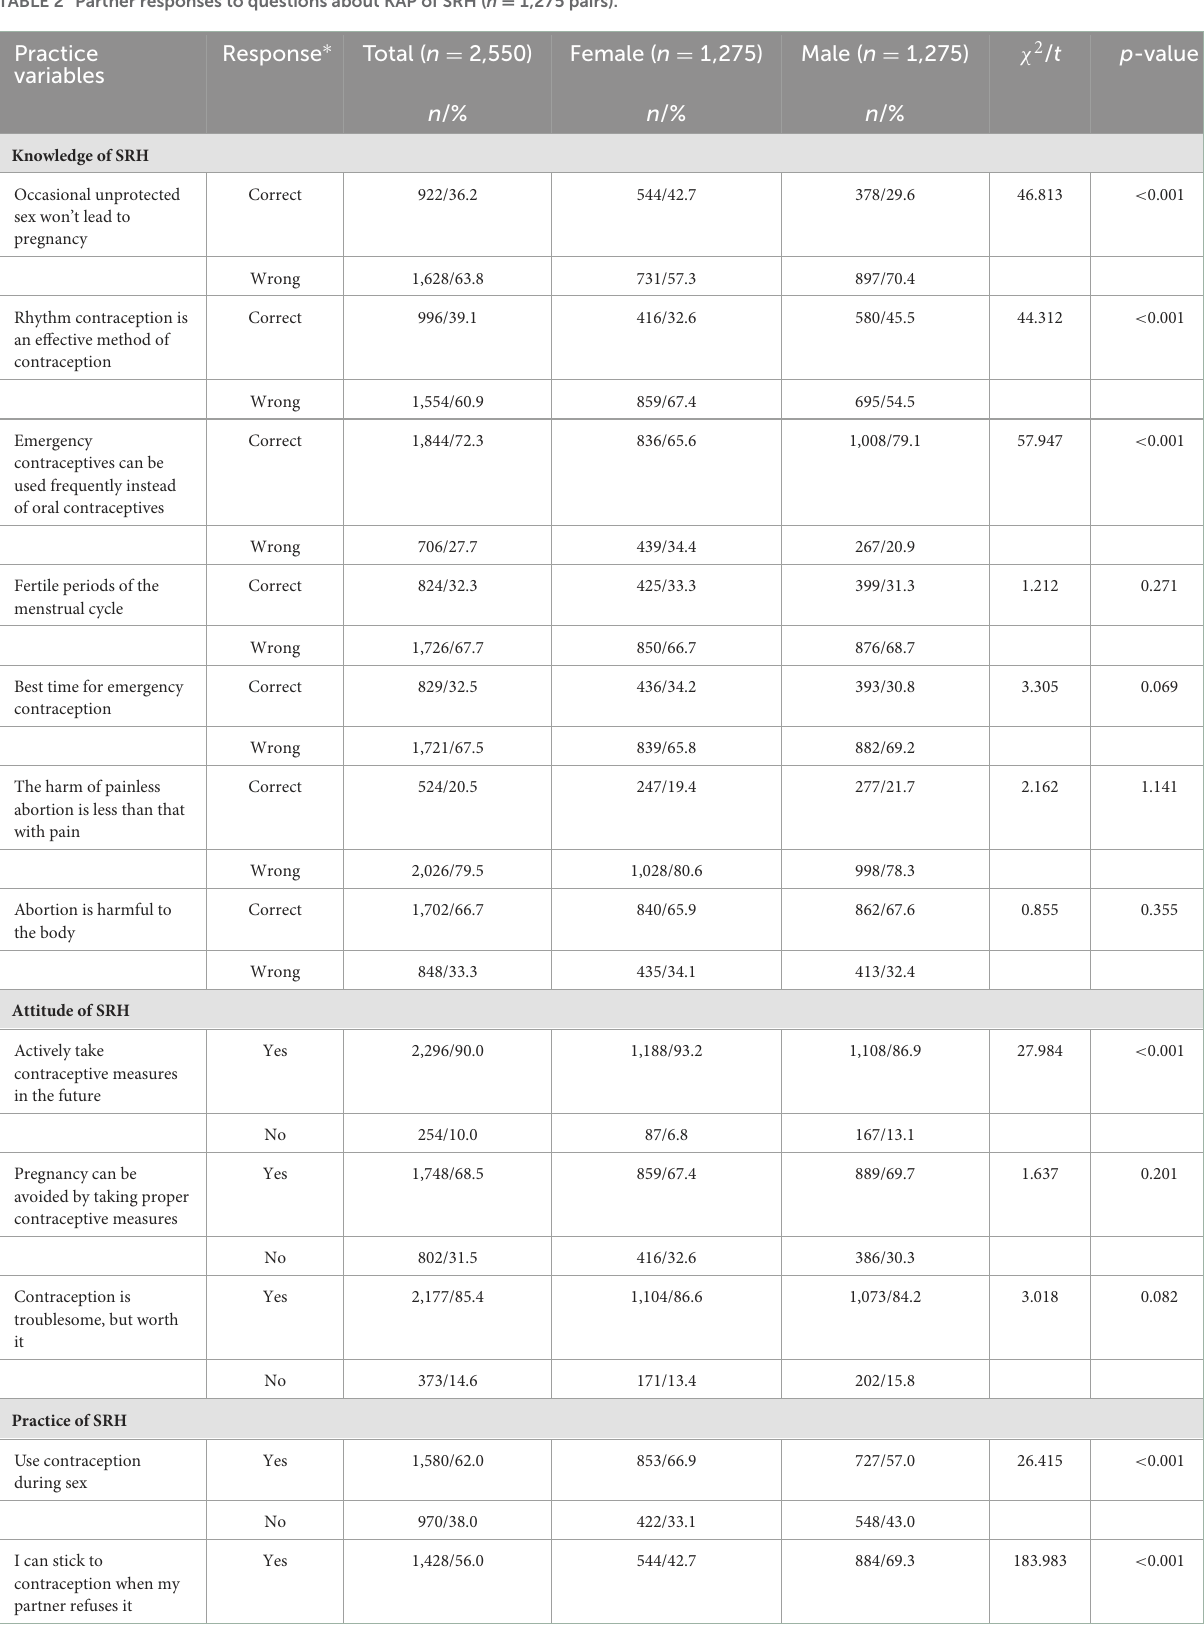
TABLE 2 Partner responses to questions about KAP of SRH ( n = 1,275